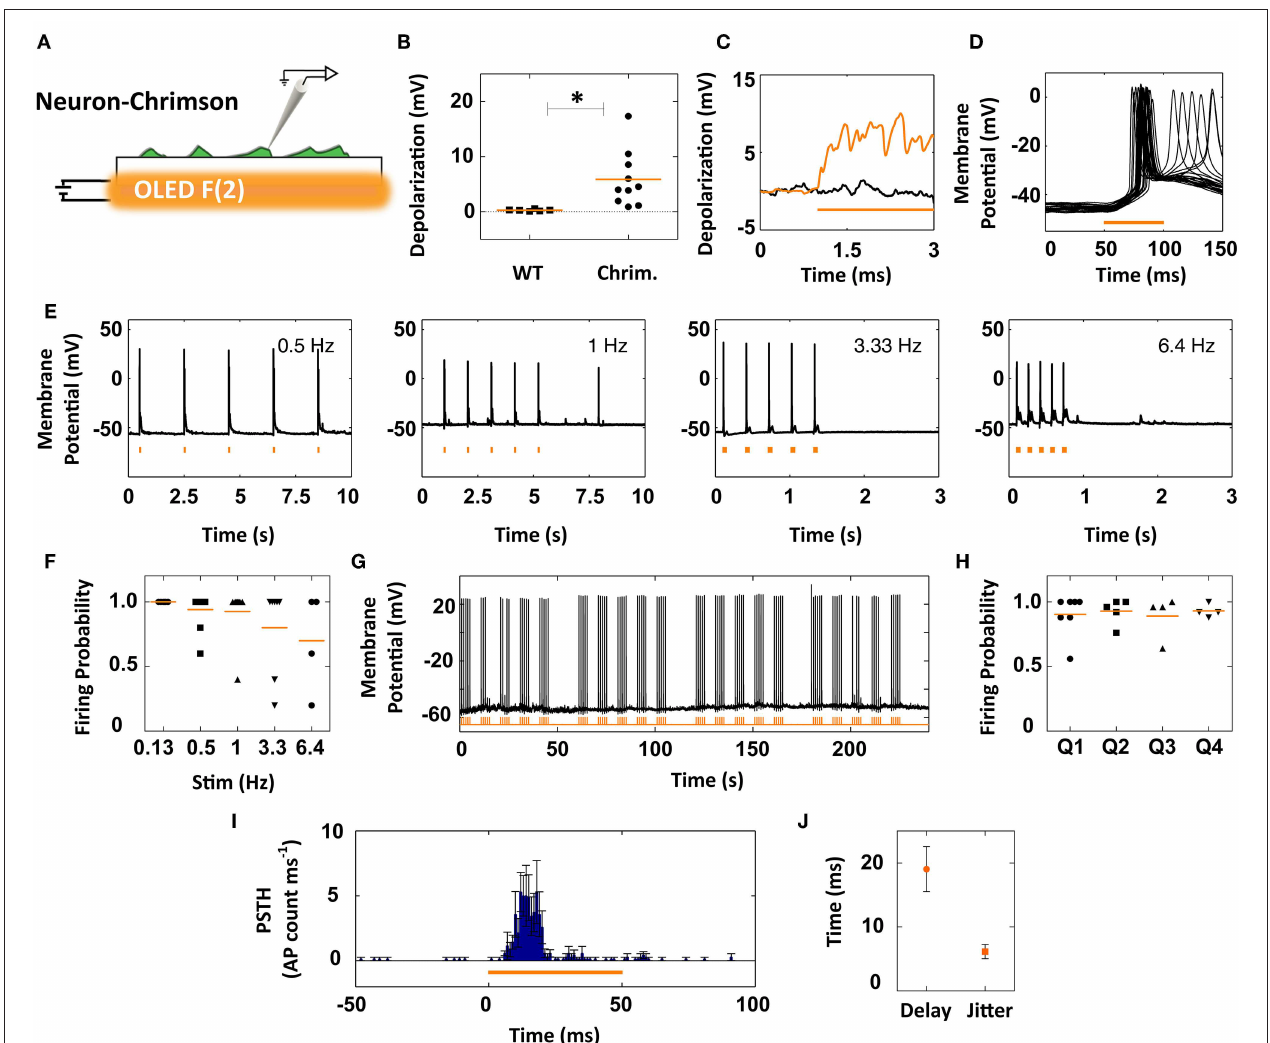
FIGURE 5 | Coupling of orange OLEDs to ChrimsonR-expressing neurons for millisecond control of action potential firing. (A) Primary neurons were transduced with lentiviral vectors encoding ChrimsonR, and responses to orange OLED illumination were recorded by patch-clamp. (B) Subthreshold responses to 50ms illumination in ChrimsonR-expressing cells. Control mock-transduced neurons (WT) showed no responses to light ( p < 0.05, Mann-Whitney U -test). (C) Representative subthreshold responses to prolonged (2s) illumination of ChrimsonR-expressing cells (orange trace) and mock-infected neurons (black trace). (D) Overlay of membrane responses of a single ChrimsonR-expressing neuron to 25 repetitions of 50ms pulses, successfully triggering action potential firing. (E) Representative traces of neurons successfully firing action potentials during five consecutive 50ms light stimuli at various inter-stimulus repetition rates. (F) Firing probability vs. stimulus frequency (0.13–6.4Hz), calculated over first five stimuli per cell (symbols); orange lines represent the group means. (G) Representative spiking activity in response to five trains (each composed of five 1 Hz-stimuli) administered at 0.1Hz. (H) Firing probability over multiple repetitions (25–100) following the stimulation protocol shown in (G) for individual cells (symbols) and group means (lines). (I) Peristimulus time histogram for the time window 50-ms-before/50-ms-after the stimulus (1ms bins). (J) Quantification of the delay and jitter of action potential firing based on the first spike per stimulus calculated across all recorded